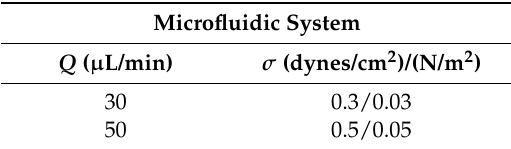
Table 3. Values for flow rate ( Q ) and shear stress ( σ ) in the microfluidic